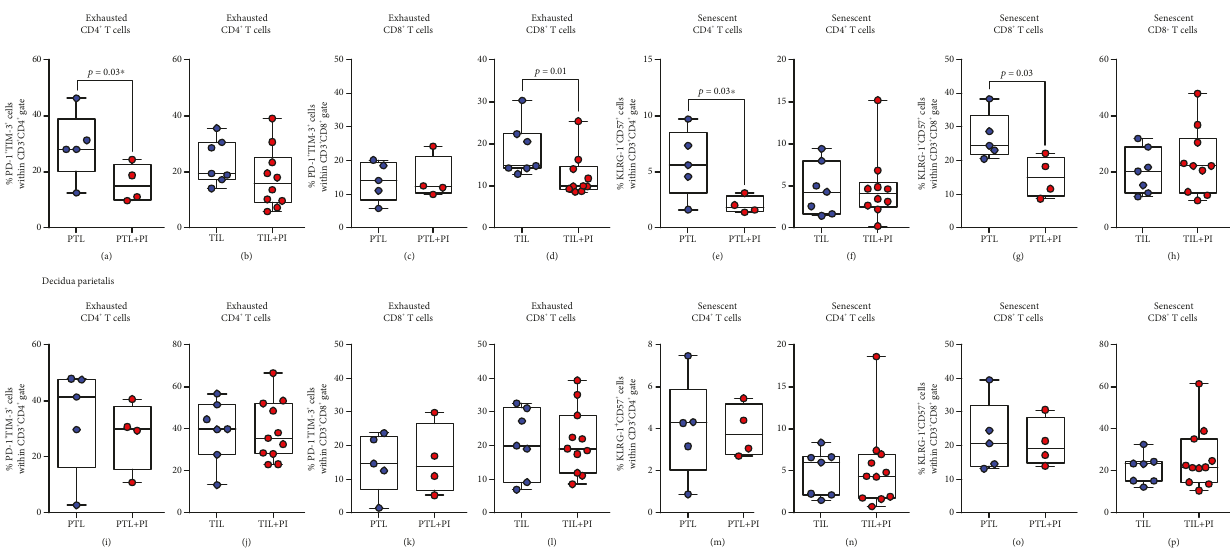
Figure 5: Proportions of exhausted and senescent CD4 + and CD8 + T cells in the decidua basalis and decidua parietalis with placental in fl ammation. The proportions of exhausted and senescent CD4 + and CD8 + T cells in the decidua basalis (a – h) and decidua parietalis (i – p) of women who underwent preterm labor with (PTL+PI) or without (PTL) placental in fl ammation or labor at term with (TIL+PI) or without (TIL) placental in fl ammation. N = 4 – 11 . Midlines — medians, boxes — interquartile ranges, and whiskers — minimum and maximum ranges. PI: placental in fl